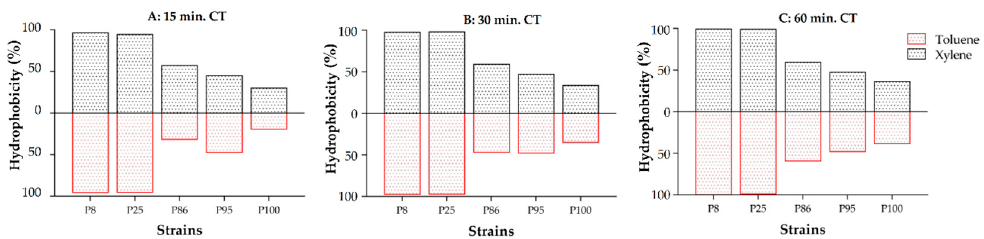
Figure 1. Adhesion of the L. plantarum five selected strains to toluene and xylene (expressed as hydrophobicity %) measured using bacterial ability to adhere to hydrocarbons (BATH) test after different contact times (CTs). A : 15 min; B : 30 min; C : 60 min.